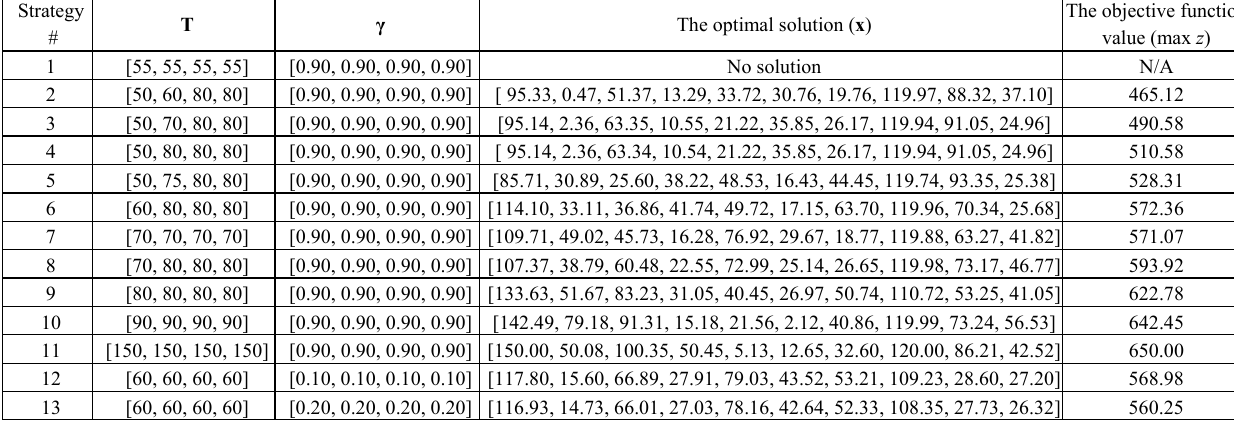
The optimal solution ( x